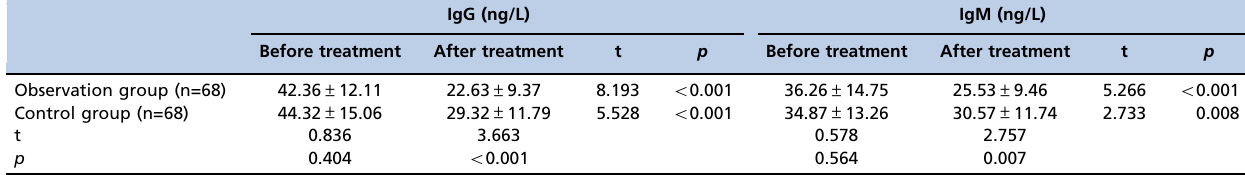
Table 3 - Expression levels of IgG and IgM.